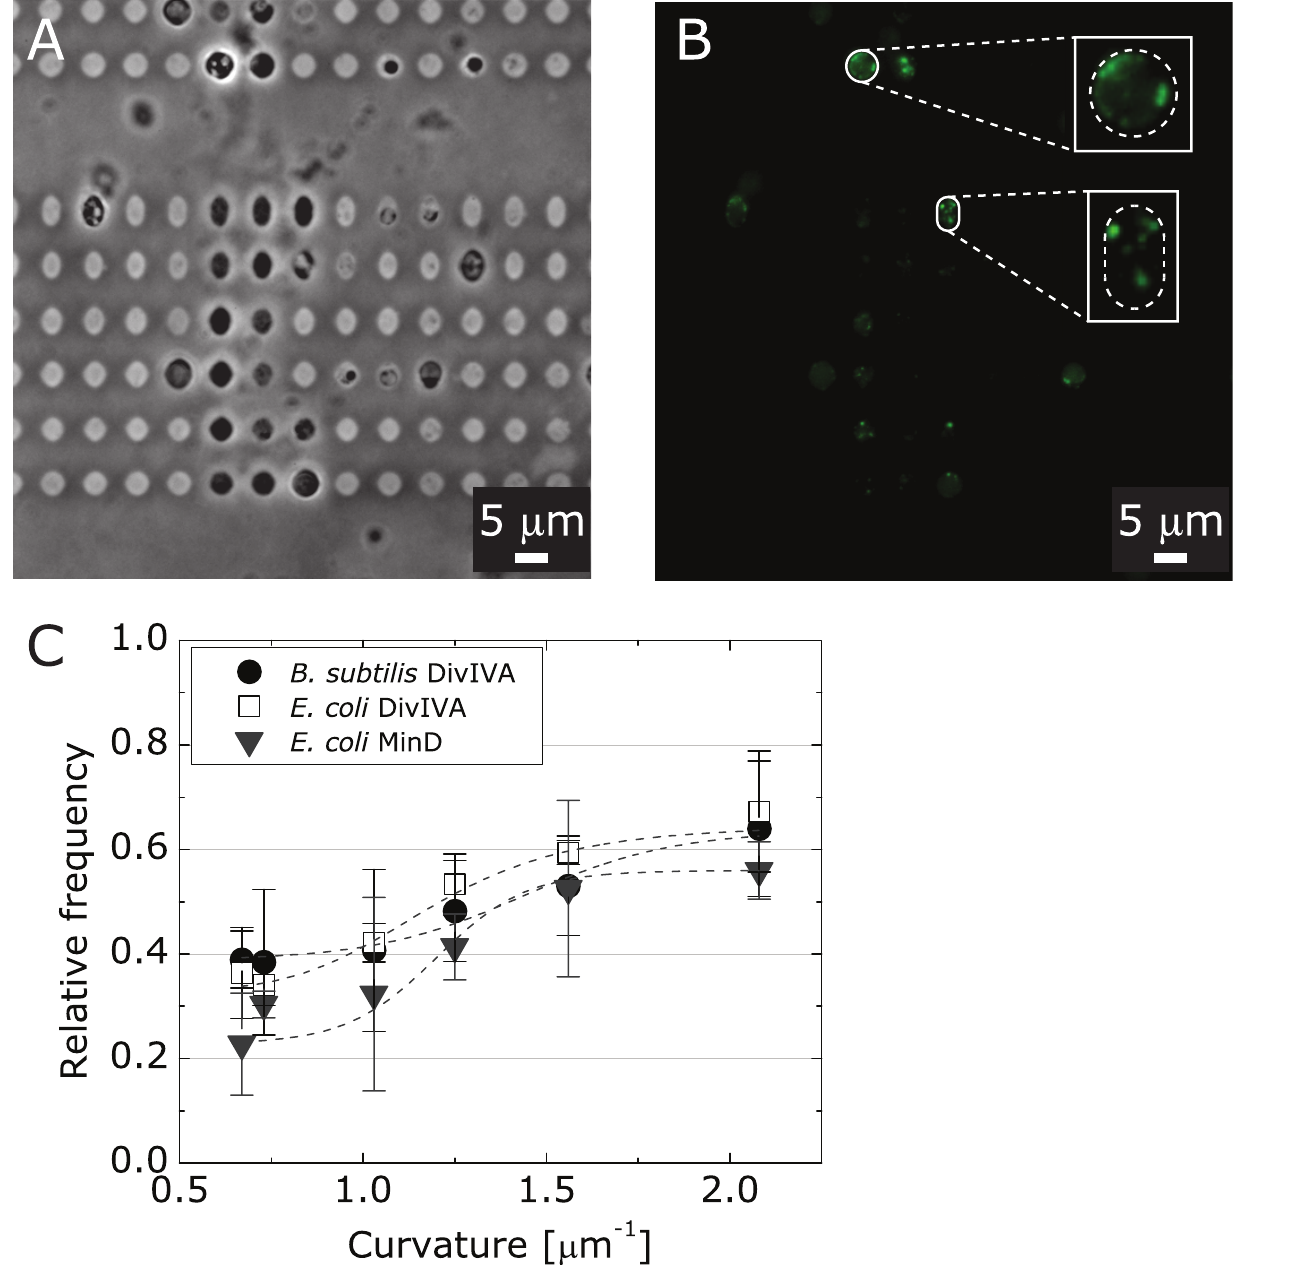
Figure 3. Analysis of DivIVA localization in spheroplasts from filamented cells of E.coli pKR196 and protoplasts from filamented cells of B. subtilis PE103. (A) A representative brightfield microscopy image of protoplasts from B. subtilis PE103 confined in agarose microchambers. (B) A fluorescence microscopy image of DivIVA-CFP in B. subtilis PE103 protoplasts confined in agarose microchambers. The images inset show the DivIVA-CFP fluorescence in two magnified protoplasts with imposed membrane curvature that is high and low negative. Scale bars: 5 m m. (C) A plot depicting the relative frequency of the DivIVA distribution in E. coli pKR196 spheroplasts (open squares) and B. subtilis PE103 protoplasts (shaded circles) and its relationship to microchamber curvature. Data for the relative frequency of MinD-YFP in spheroplasts of E. coli MG1655 pFX40 cells (shaded triangles) versus curvature for are provided for comparison to DivIVA-GFP and DivIVA-CFP.